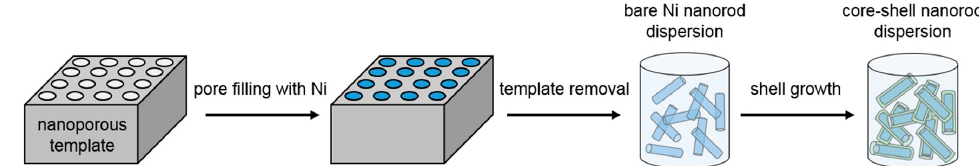
Figure 9. Schematic sketch of the synthesis procedure for core-shell nanorods. First, the pores of a nanoporous template are filled with Ni by electrodeposition. Then, the template is removed so that a dispersion of bare Ni nanorods is obtained. Finally, nanorods in solution are coated by a metal or metal oxide shell.